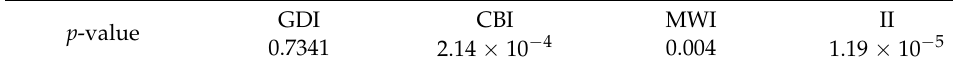
Table 4. List of p -values for regional (spatial) averaged GDI trends.